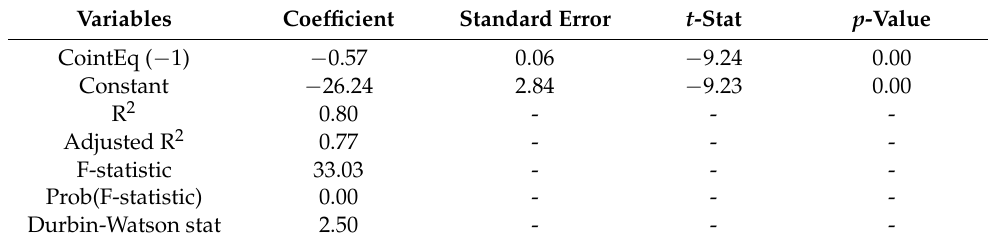
Table 4. Error Correction Model (ECM) Estimation.